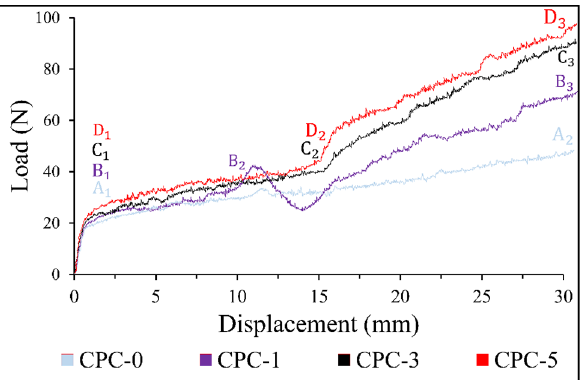
Figure 5. The load–displacement curves of the different cement samples.